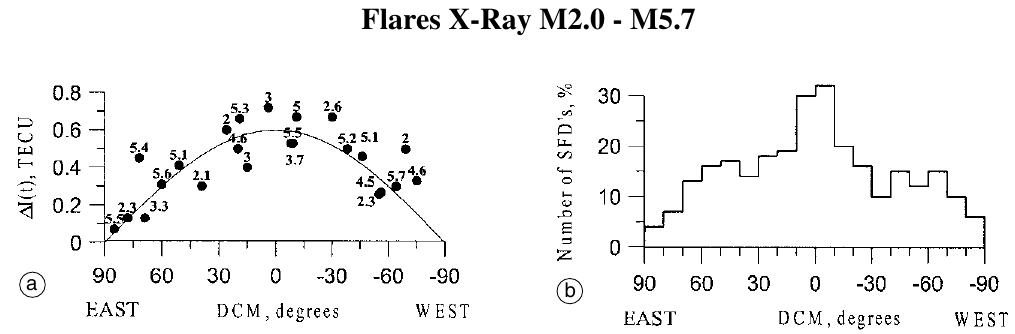
Fig. 5a,b. CMD dependence of the increment of the mean amplitude of the TEC response to solar flares (in the range of X-ray class M 2.0 – M 5.7 (dots), cos(CMD) fitting curve for solar flares in the X-ray range M 2.0 – M 5.7 (solid lines) (a); percentage of H α -flares accompanied by SFD’s as a function of the central meridian distance of the H α flare